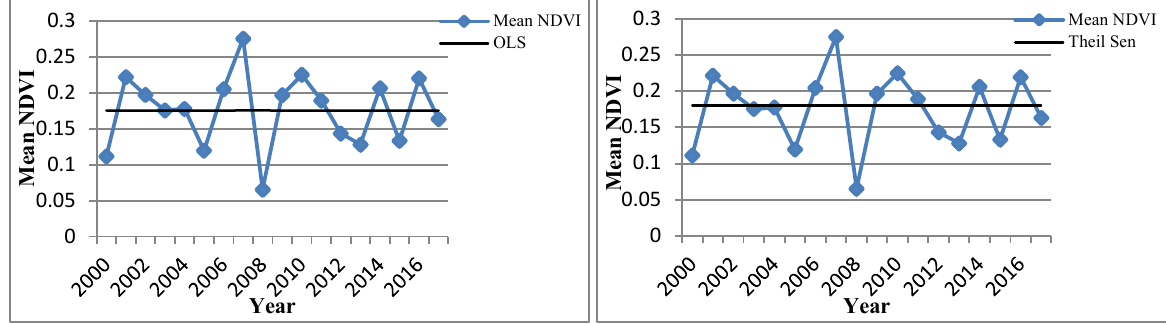
Figure 3. NDVI trend variation using OLS and Theil-Sen methods during